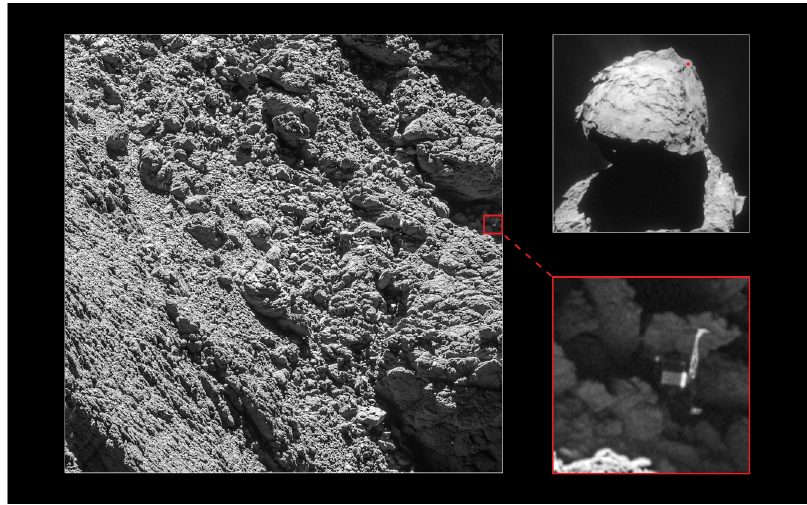
Figure 11. Photo of the Philae lander, stuck into a crack on comet 67P/Churyumov-Gerasimenko, revealed by the OSIRIS narrow-angle camera on the Rosetta orbiter. Retrieved from http://www.esa.int/var/esa/storage/images/esa_multimedia/images/2016/09/philae_found/16114811- 1-eng-GB/Philae_found.jpg.